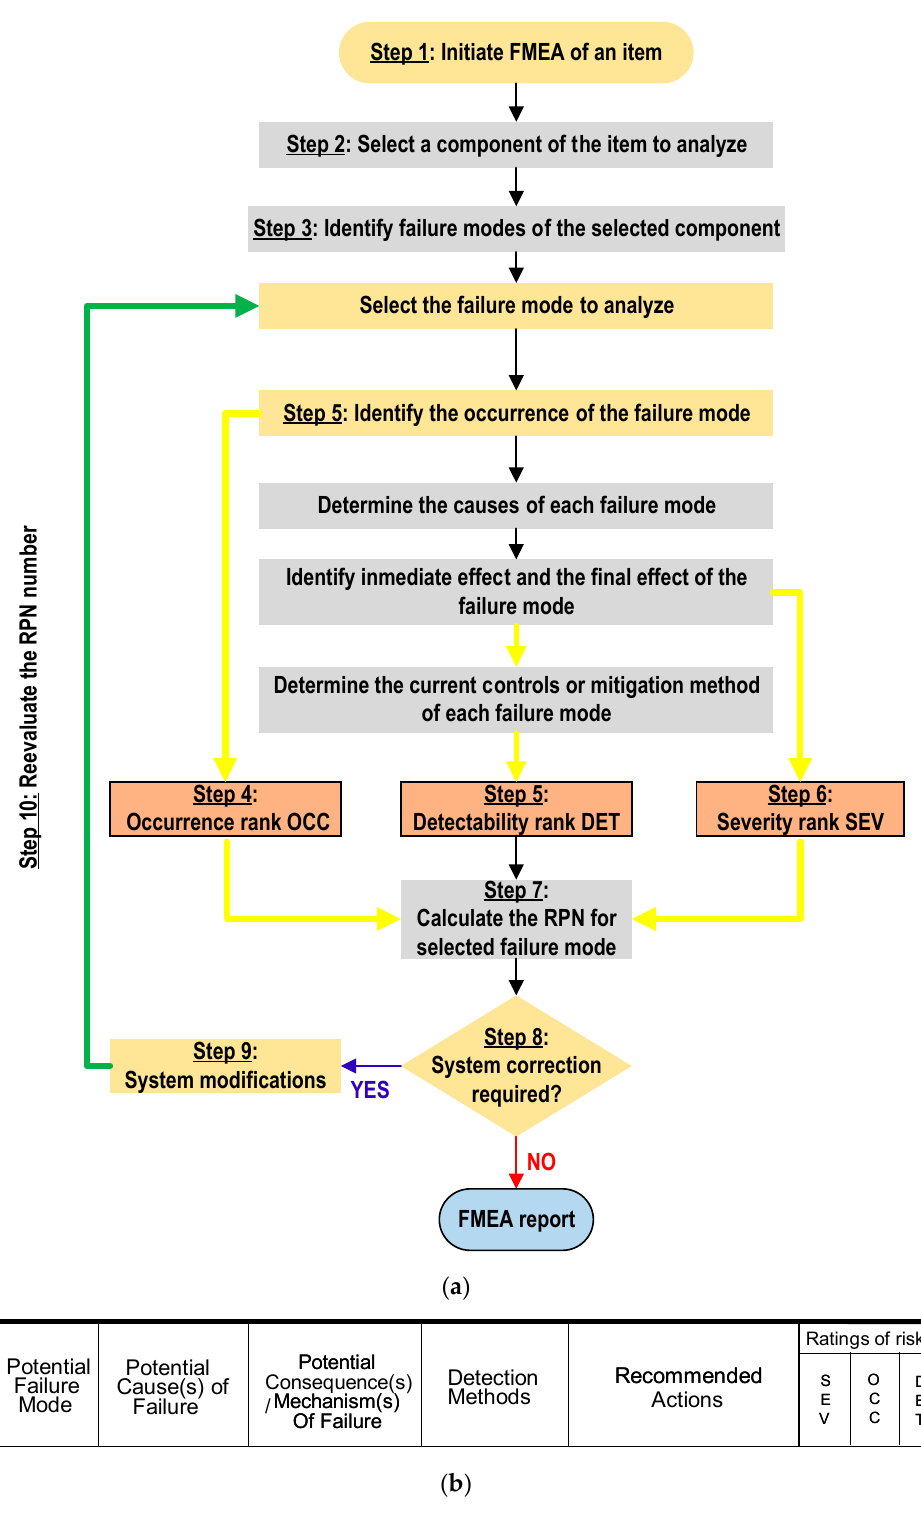
Figure 1. ( a ) FMEA flowchart from [17,19]. ( b ) Example of an FMEA worksheet line and respective Figure1. ( a )FMEAflowchartfrom[17,19]. ( b columns.